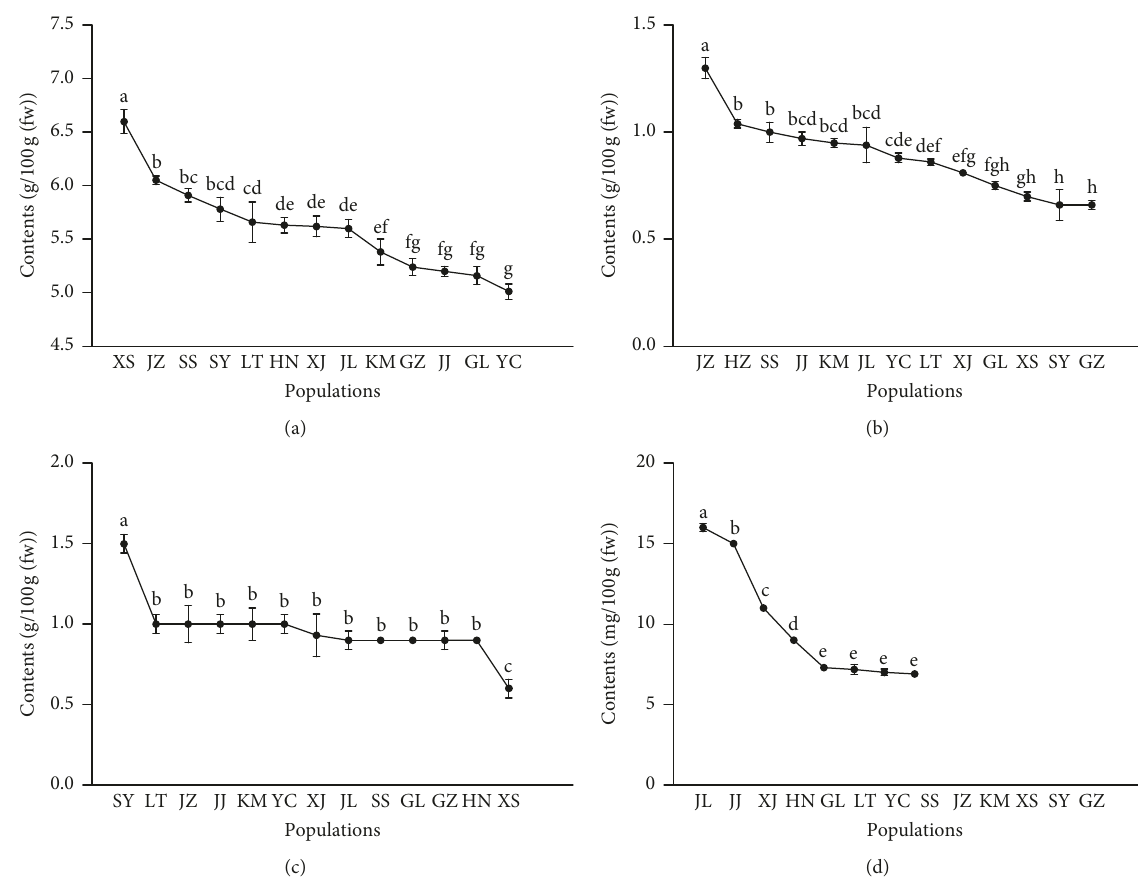
Figure 3: Main nutrient element contents of 13 Lycium chinense populations in China. Bars: standard errors, n � 3. fw, fresh weight. Lowercase letters identify groups of populations that differ significantly ( P < 0 . 05). Missing data (in vitamins panel): no content detected (see Figure 1 for population locations). (a) Crude protein, (b) reducing sugar, (c) crude fibre, and (d)